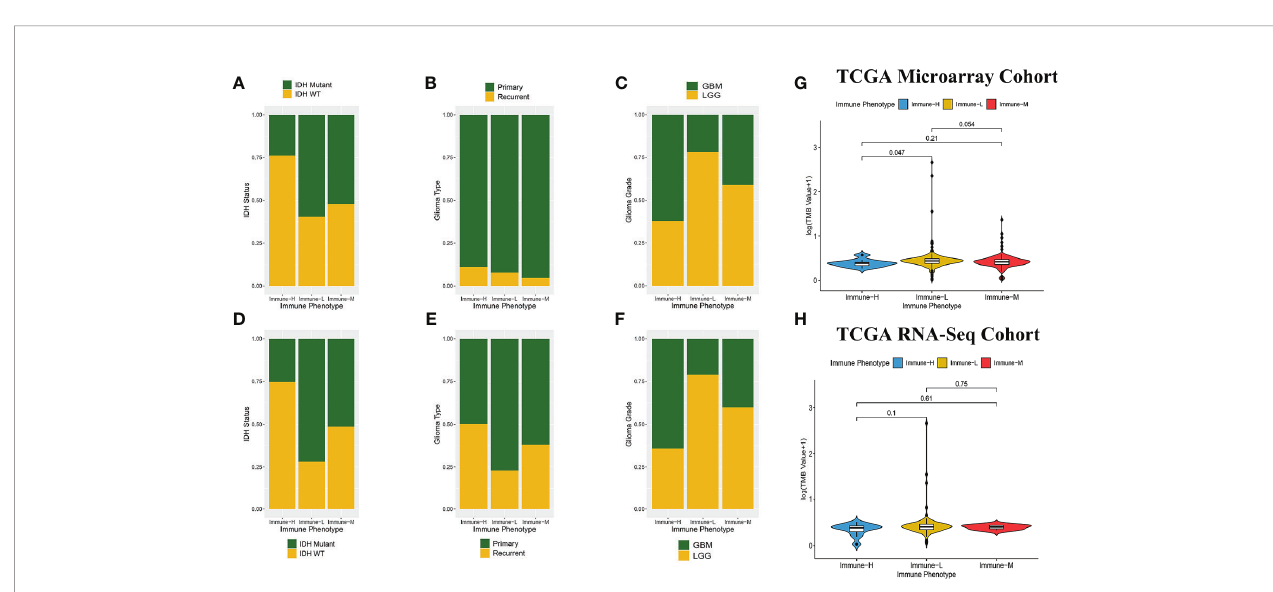
FIGURE 8 | Comparison on IDH status, glioma type, grade and tumor mutation burden among immune phenotypes. (A) Proportion of IDH-mutant and IDH-wild type glioma in three phenotypes in CGGA microarray cohort. (B) Proportion of primary and recurrent glioma in three phenotypes in CGGA microarray cohort. (C) Proportion of LGG and GBM in three phenotypes in CGGA microarray cohort. (D) Proportion of IDH-mutant and IDH-wild type glioma in three phenotypes in CGGA RNA-seq cohort. (E) Proportion of primary and recurrent glioma in three phenotypes in CGGA RNA-seq cohort. (F) Proportion of LGG and GBM in three phenotypes in CGGA RNA-seq cohort. (G) Violin plot showing comparison of TMB based on immune-phenotypes in TCGA microarray cohort. (H) Violin plot showing comparison of TMB based on immune-phenotypes in TCGA RNA-seq cohort. LGG, low grade glioma; GBM,